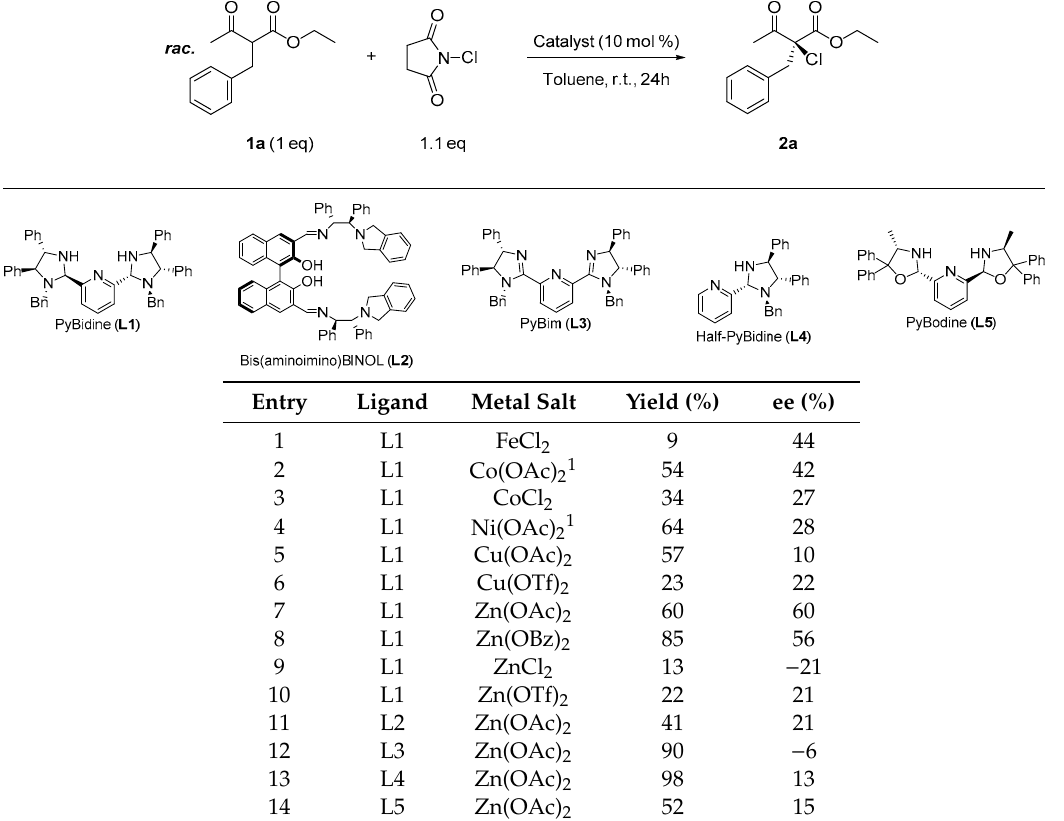
β -ketoester. Table 1. First screening of metal catalysts for asymmetric chlorination of β